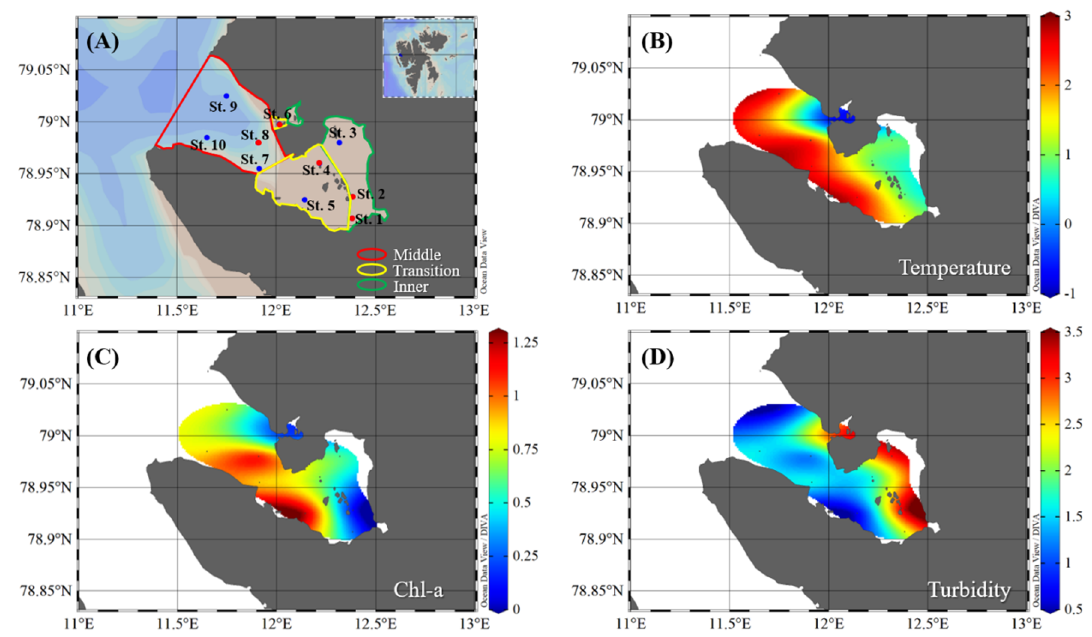
Figure 1. ( A ) Sampling stations in Kongsfjorden. The blue dots indicate productivity stations. Surface distribution of ( B ) water temperature ( ◦ C), ( C ) chlorophyll a (chl-a) (mg · m − 3 ), and ( D ) turbidity (FTU)